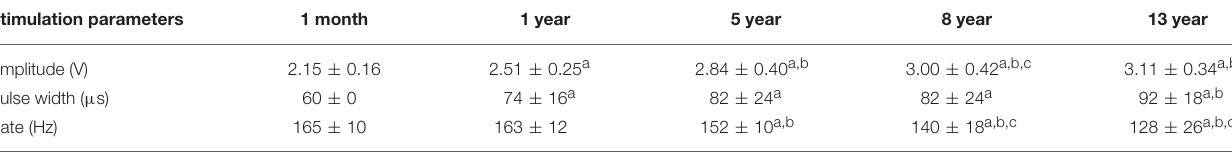
* Data represent mean and standard deviation. a p significant compared with 1 month after